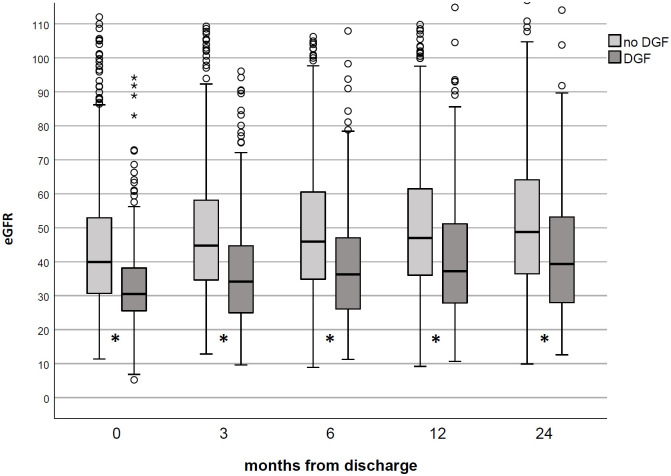
Renal function in studied population according to DGF occurrence.KTs who experienced DGF had a low eGFR (CKD-EPI formula) vs. no DGF patients at any time-point. *p<0.001.